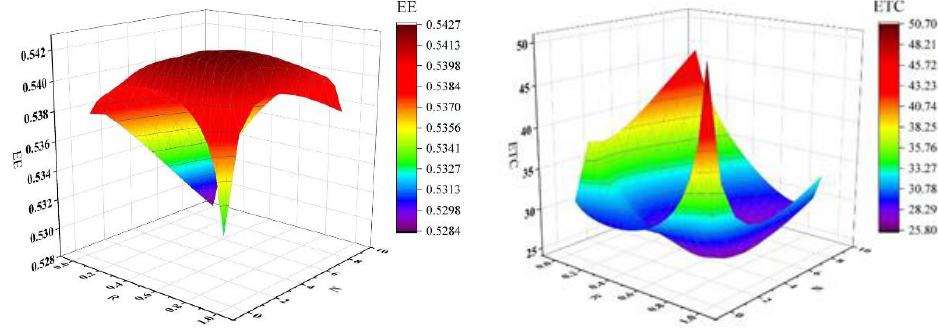
Figure 6. Maintenance cost per unit and energy efficiency under different threshold combinations.